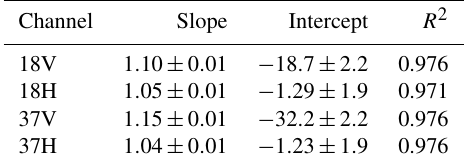
Table 3. Estimated linear correction coefficients, for the inter- calibration of the SMMR observations at 18 and 37GHz, vertical and horizontal polarizations, with respect to GMI observations over the continents. The uncertainties are also added (computed with a t test at the 99% confidence